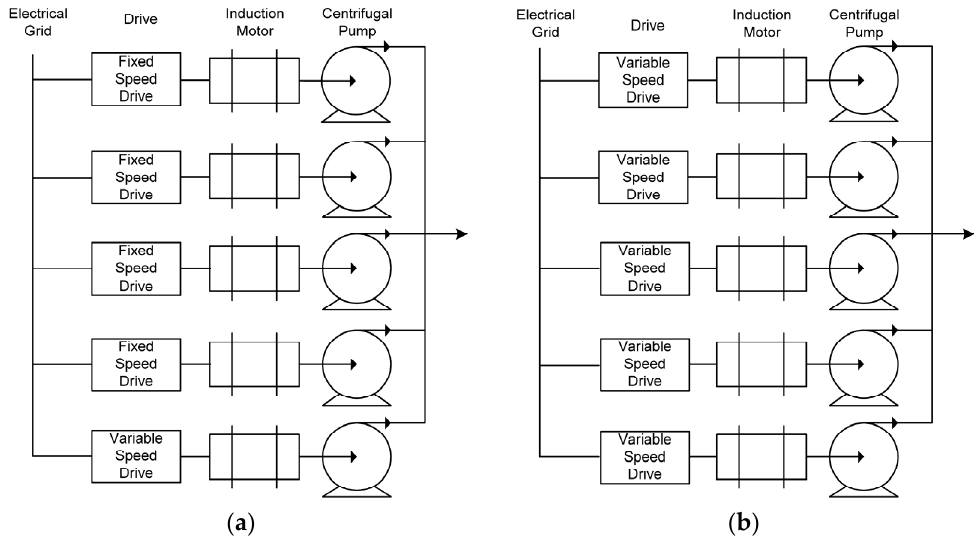
Figure 3. System of multiple pumps in parallel: ( a ) with a single pump at variable speed; ( b ) with all pumps at variable speed.